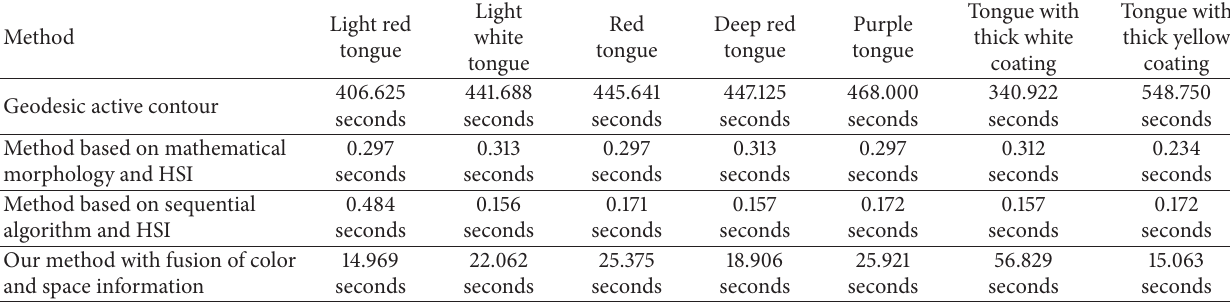
Table 3: Efficiency comparisons of 4 kinds of tongue image extraction